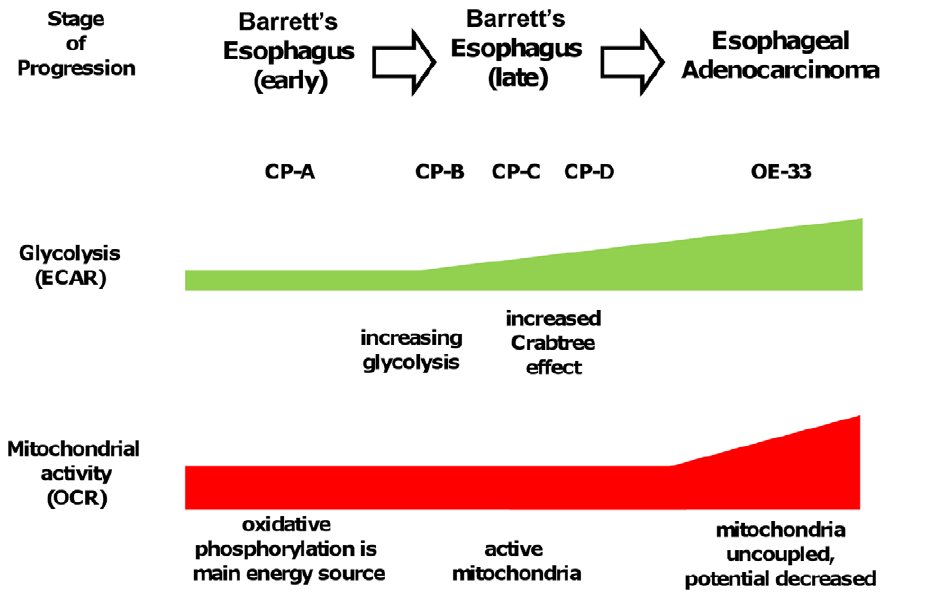
Figure 5. Barrett’s esophagus progression to esophageal adenocarcinoma involves an intermediate metabolic stage with increased glycolysis and functional mitochondria. Early-stage BE cells (e.g. CP-A), rely mainly on mitochondrial oxidative phosphorylation for energy needs prior to the glycolytic increase which occurs in late-stage BE cells (CP-B, CP-C and CP-D), which demonstrate elevated ECAR (all) and the Crabtree effect (CP-C and CP-D). Finally in esophageal adenocarcinoma (OE-33) mitochondrial uncoupling occurs with increased OCR and glycolysis.